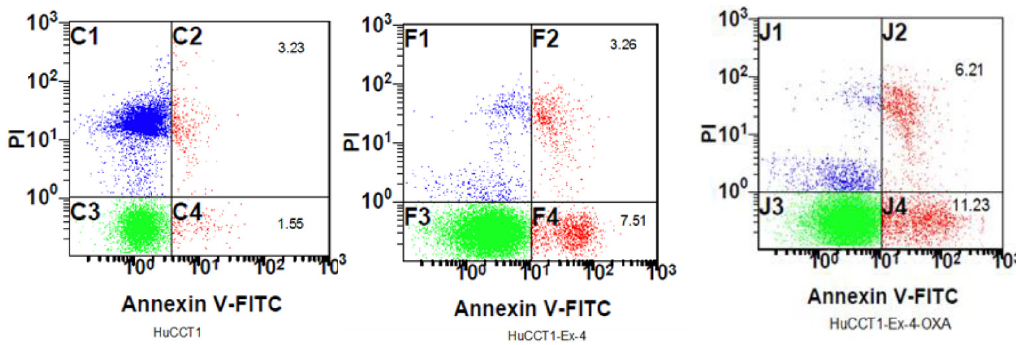
Figure 5. Cell apoptosis was detected by flow cytometry.